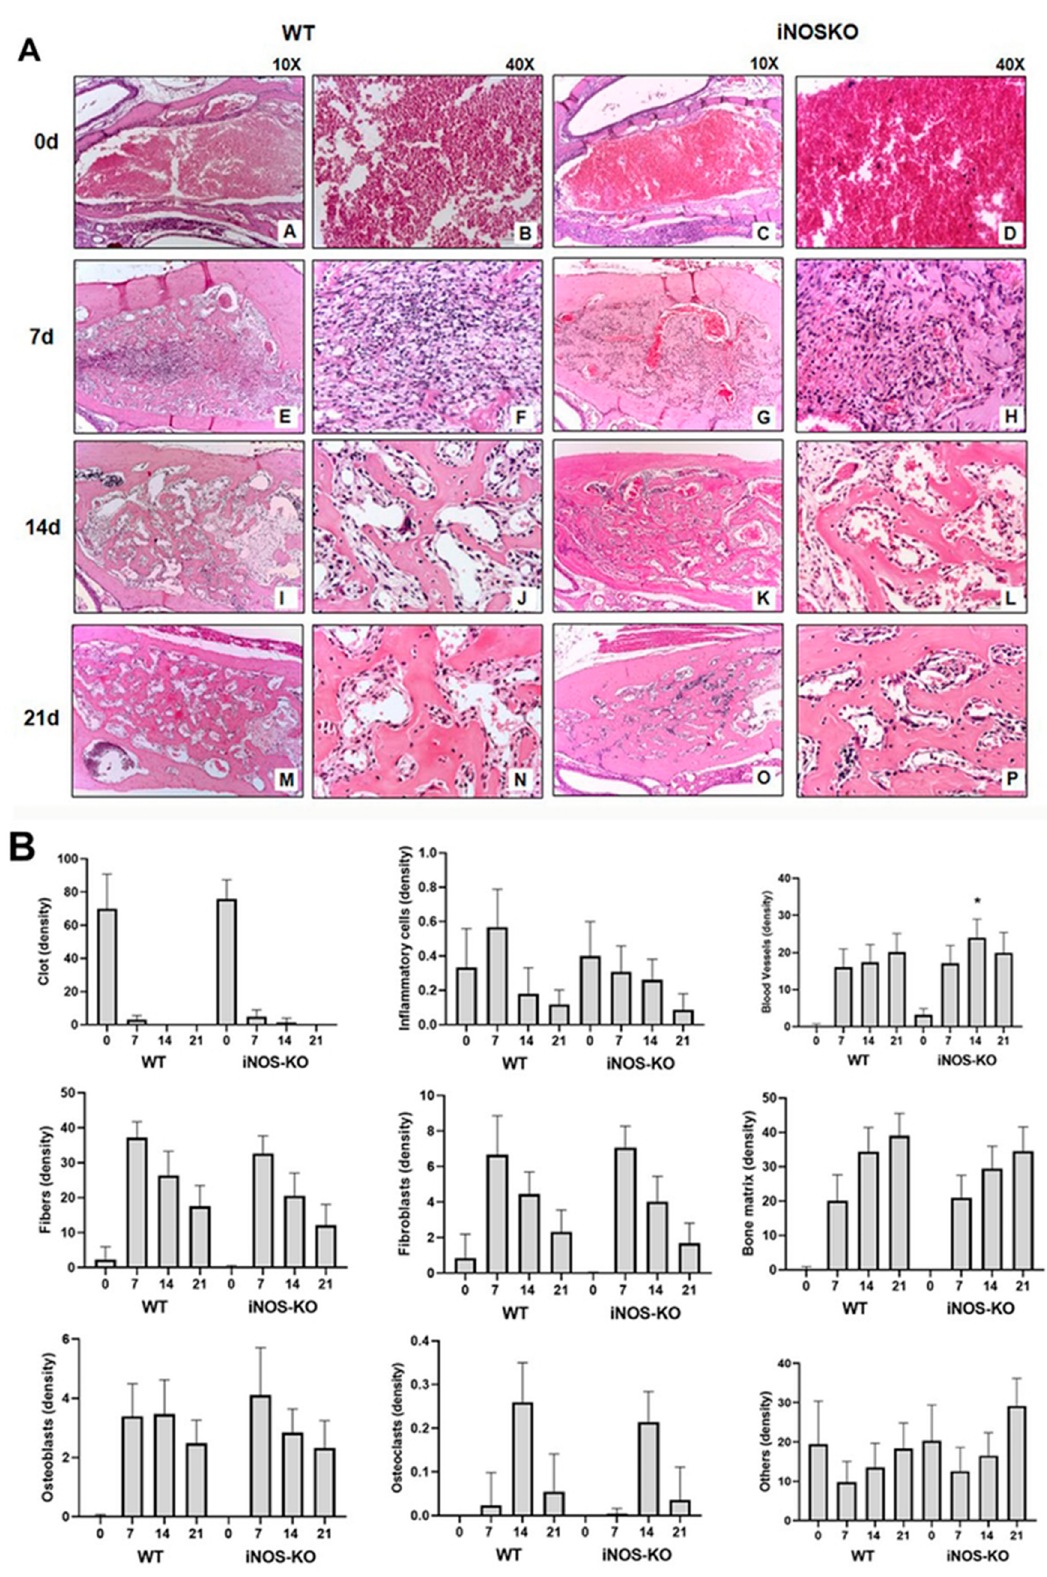
Figure 3- Histological and histomorphometric analysis of the alveolar bone healing analysis of the kinetics bone healing process in C57Bl/6 WT and iNOS-KO mice. Samples from C57BL/6 wild-type (WT) and iNOS-KO mice were subjected to histological and histomorphometric analyses at zero, seven, 14, and 21 days post tooth extraction to evaluate the kinetics of the bone healing process. (A) Photomicrographs representing the middle region of the dental alveolus in 10× and 40× magnifications. (B) Results presented as the means of density for each structure of the alveolar socket: collagen fibers, fibroblasts, blood vessels, inflammatory cells, clot, and other components (empty space left by intercellular liquid and spaces). Moreover, the results show the total density of connective tissue (represented by the sum of collagen fibers, fibroblasts, blood vessels, and inflammatory cells). The results represent the values of the mean and standard deviation in each of the periods analyzed; *represents the differences (p<0.05) between iNOS and WT group at each time